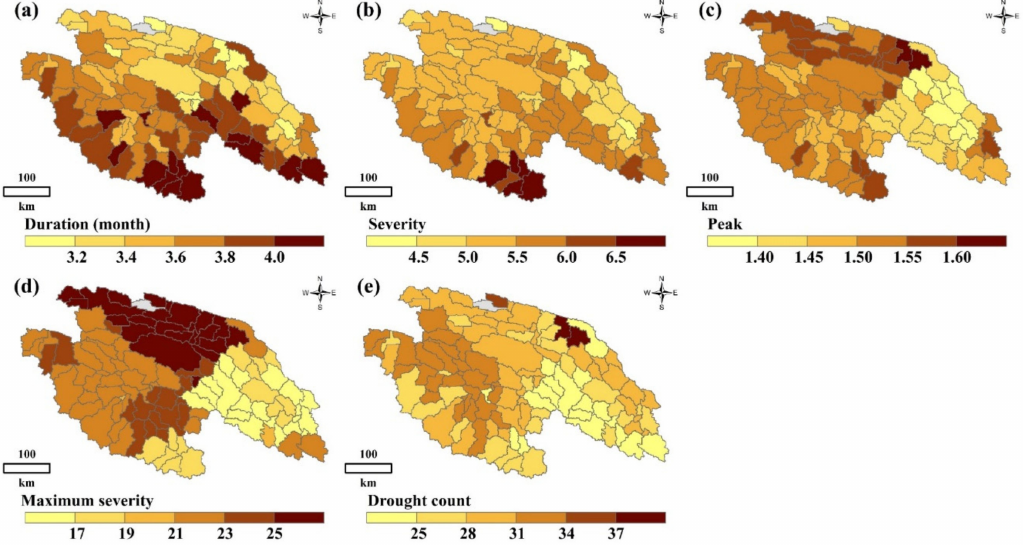
Figure 7. Spatial distribution of drought duration ( a ), severity ( b ), peak ( c ), maximum severity ( d ), and drought count ( e ) obtained on the basis of SSDI-6 values over YRSR during